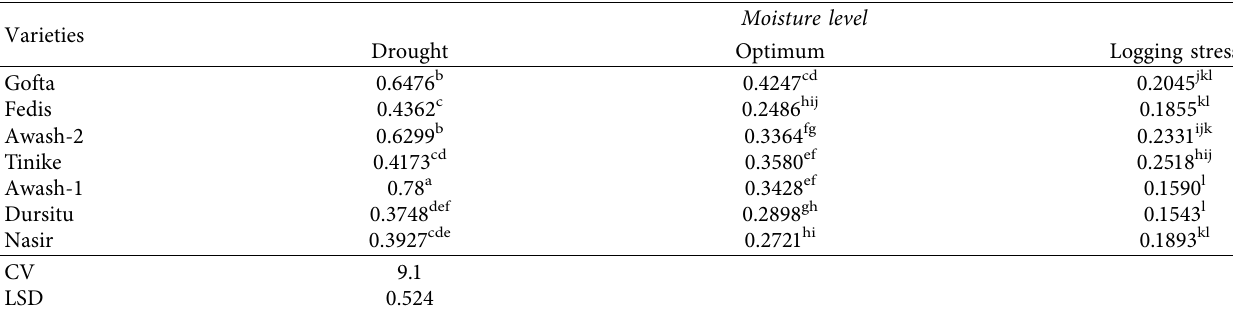
Table 8: Efects of common bean varieties and irrigation intervasl on proline c ( μ g/g) content under lath house from June